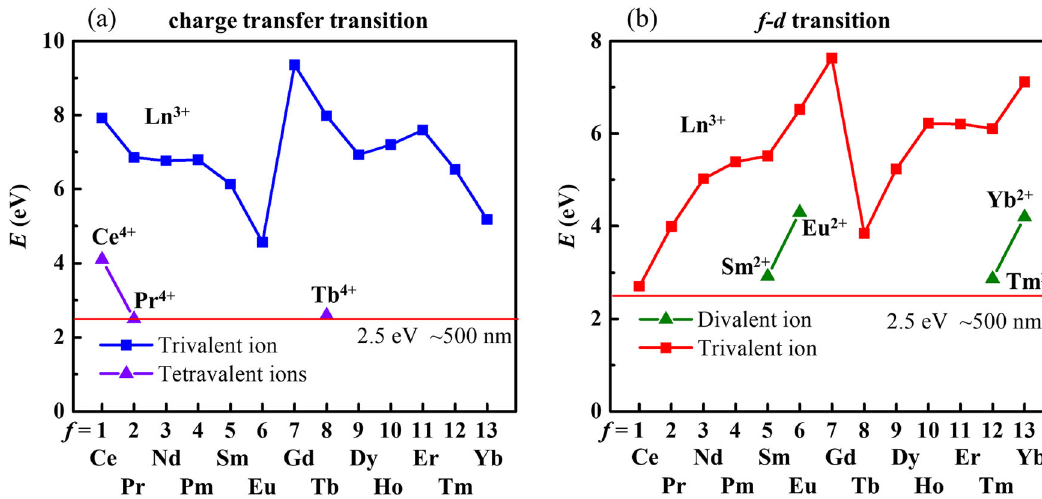
Fig. 9 The energy of transition. a, b The energy required for ( a ) charge transfer and ( b ) f-d transition of Ln 3 + and Ln 4 +